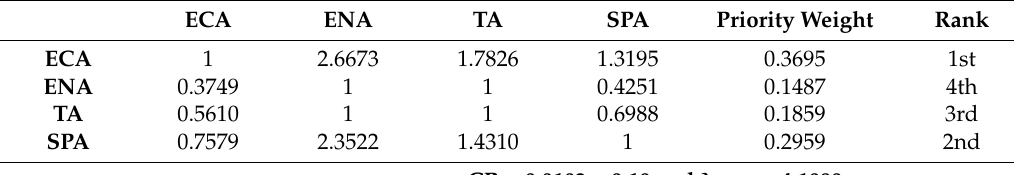
Table A3. Pair-wise comparison matrix of criteria with respect to goals along with the priority weight.